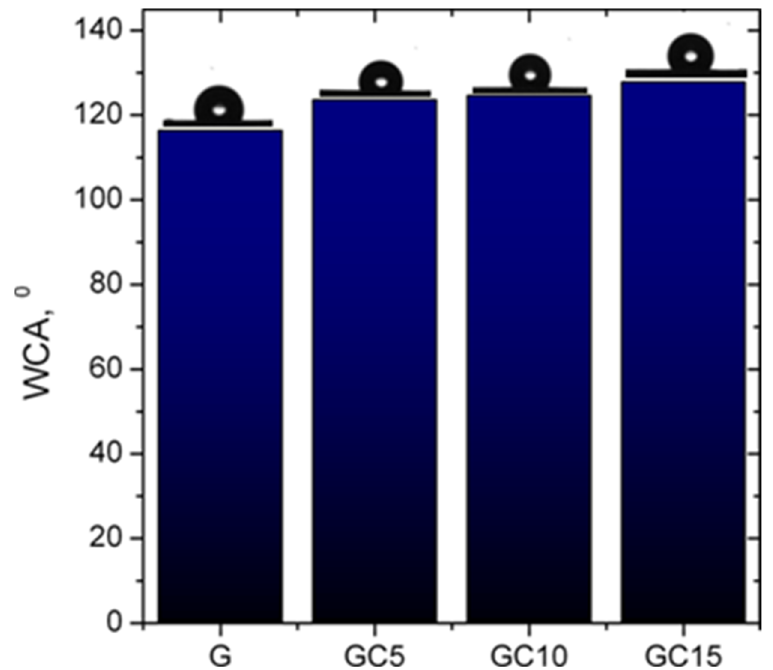
Figure 9. Values for water contact angles of the studied films and the images of the droplets on the surfaces of the samples.